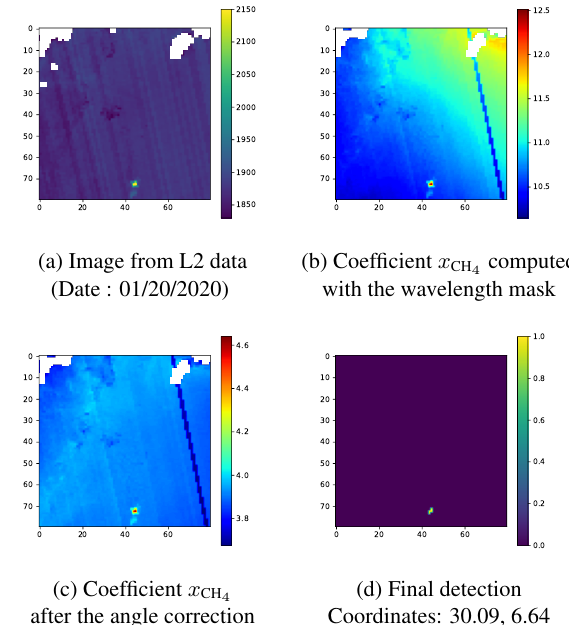
Figure 1. On all images, pixels in white are discarded pixels (cloudy for example). Figure (a) shows the L2 data with a methane plume at the bottom. Figures (b) and (c) show the evolution of the coefficient x CH estimated from L1B data at 4 each step of the algorithm. Figure (d) shows the final detection, performed